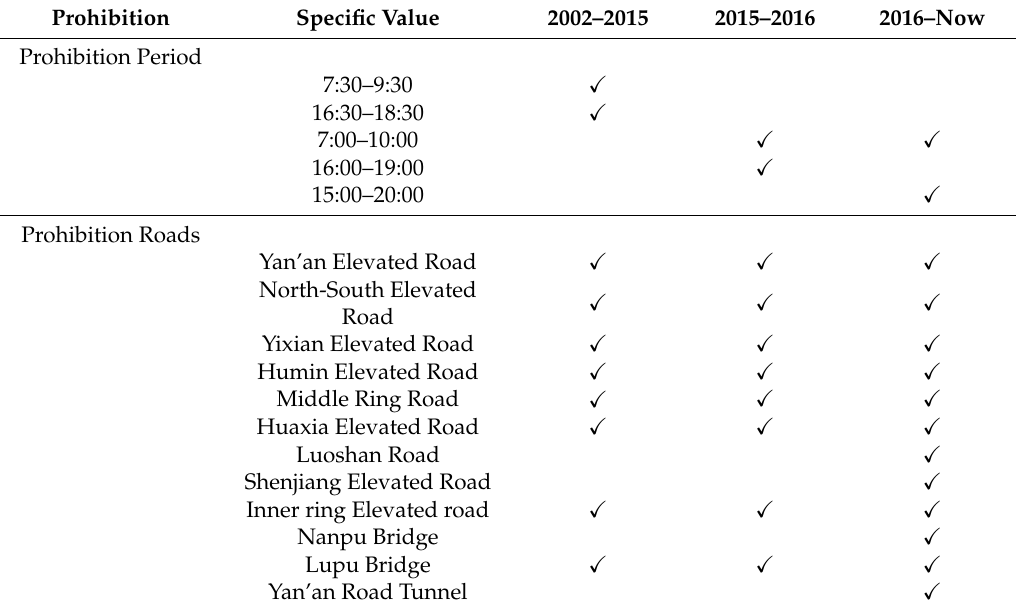
Table 1. Prohibition period and prohibition road segments in different